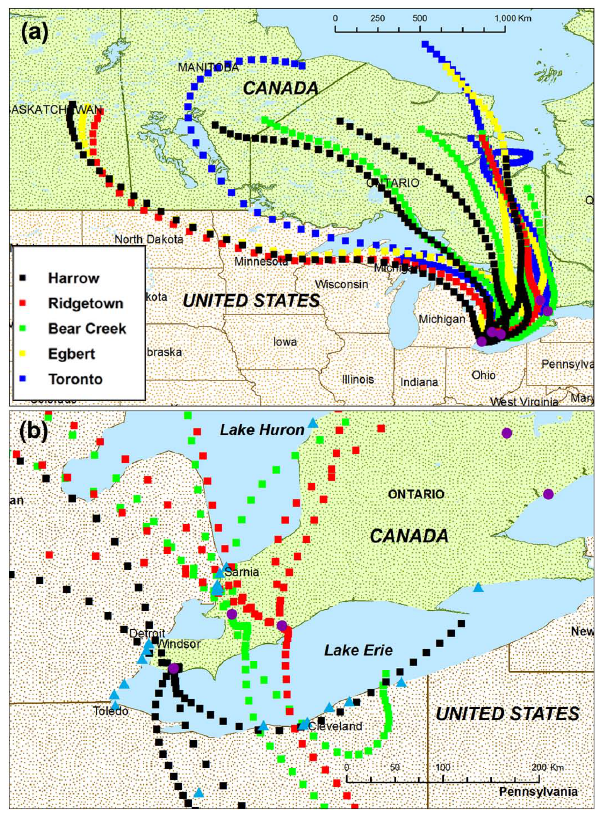
Fig. 7. 48-h back trajectories of all Class I events (a) at the five sites and 24-h back trajectories of 18 Class II events (b) at the near- border sites. Dots and triangles represent the locations of the five monitoring sites and coal-fired power plants, respectively. Back tra- jectory data from 28 June to 30 June were not available.